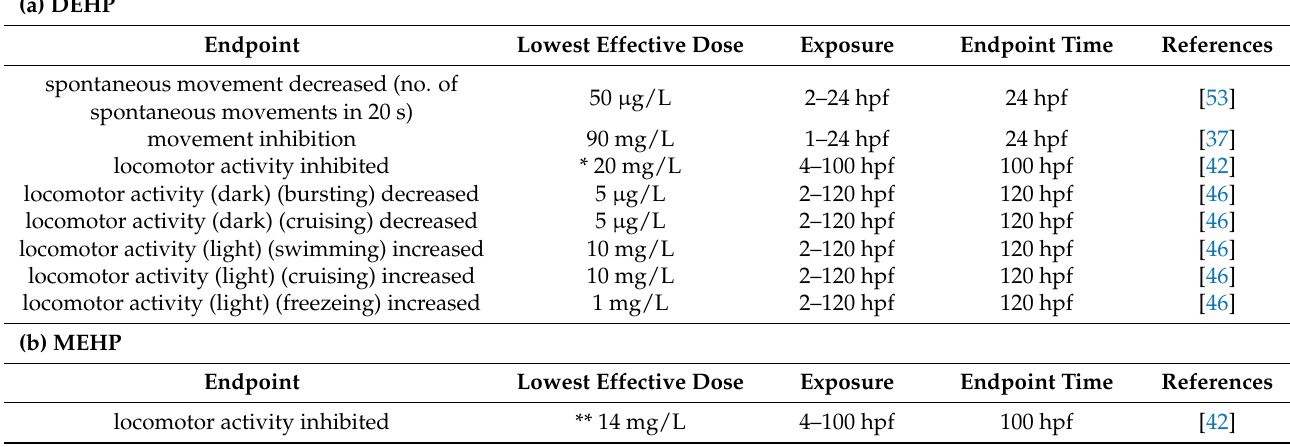
Table 5. Behavioral toxicity from acute exposures to (a) DEHP and (b) MEHP on zebrafish embryos. * The concentration was converted from nM or µ M using the molar mass of DEHP 390.57 g/mol. ** The concentration was converted from nM or µ M using the molar mass of MEHP 278.34